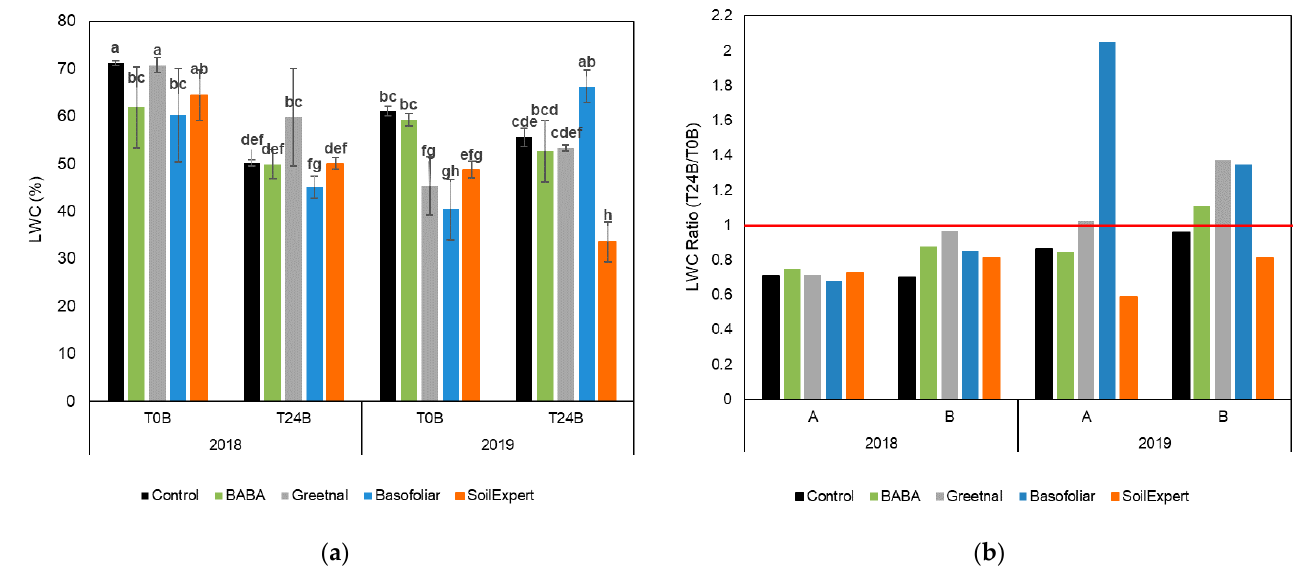
Figure 2. ( a ) Leaf water content (LWC (%)) in Vitis vinifera var. Tempranillo before (T0B) and after (T24B) the second foliar application with distiller water (C), BABA, or three commercial biostimulants (Greetnal (GT), Basofoliar (BF), or SoilExpert (ST)) in the 2018 or 2019 season. ( b ) Ratio of the LWC between T24B and T0B for the two subplots (A and B) and seasons. Different letters indicated significant differences according to Duncan’s test after ANOVA.